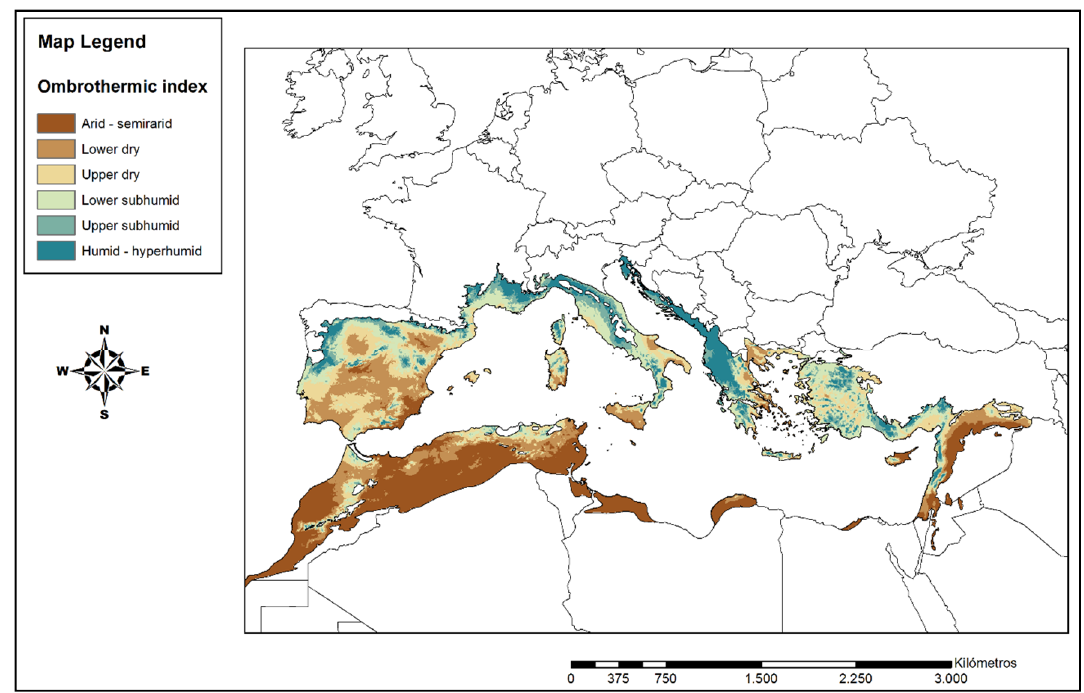
Figure 1. Optimum areas for the development of Juniperus oxycedrus group. Optimal areas range from arid upper to upper dry upper arid-semi-arid and upper dry ombrotype.